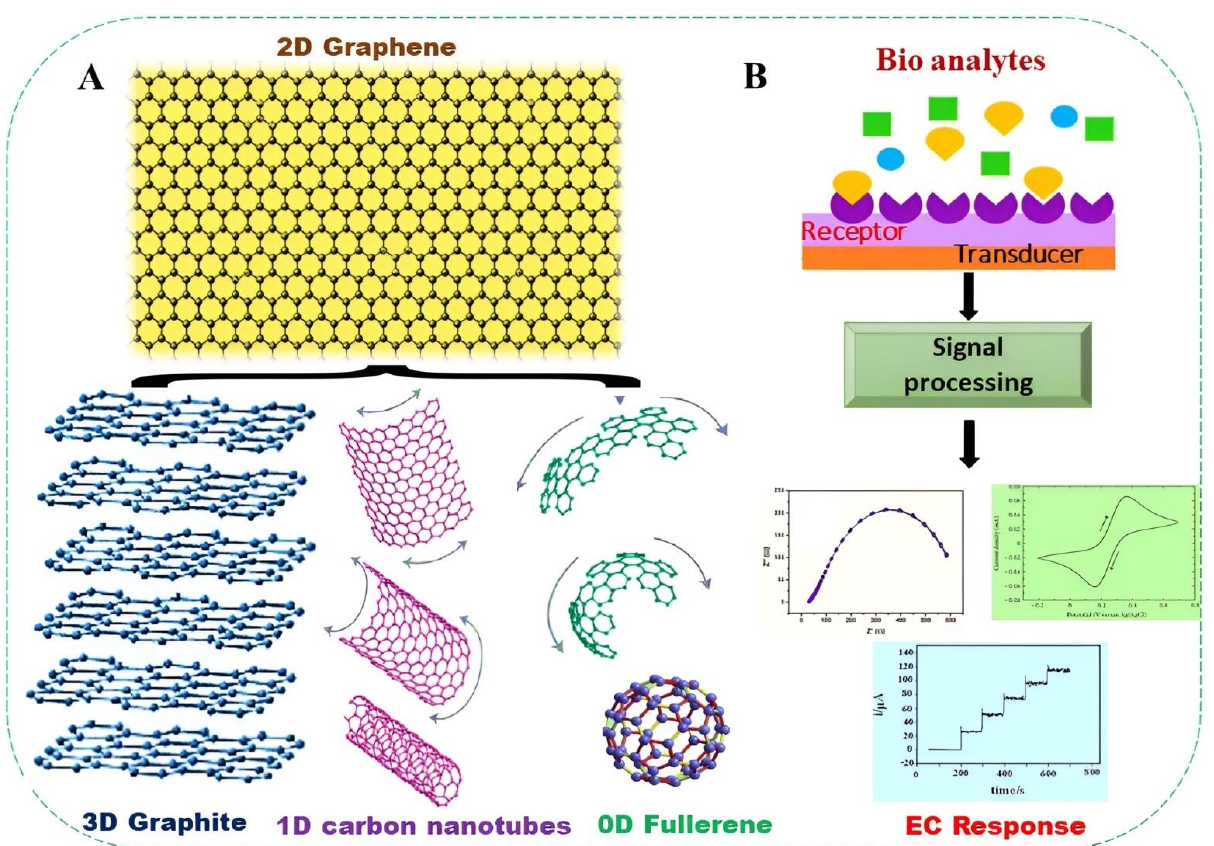
Figure 1. ( A ) 2D GR as the primary constituent of various carbon − based materials. ( B ) A simplistic representation of various components involved in detecting bioanalytes using EC sensor and related transducer responses.